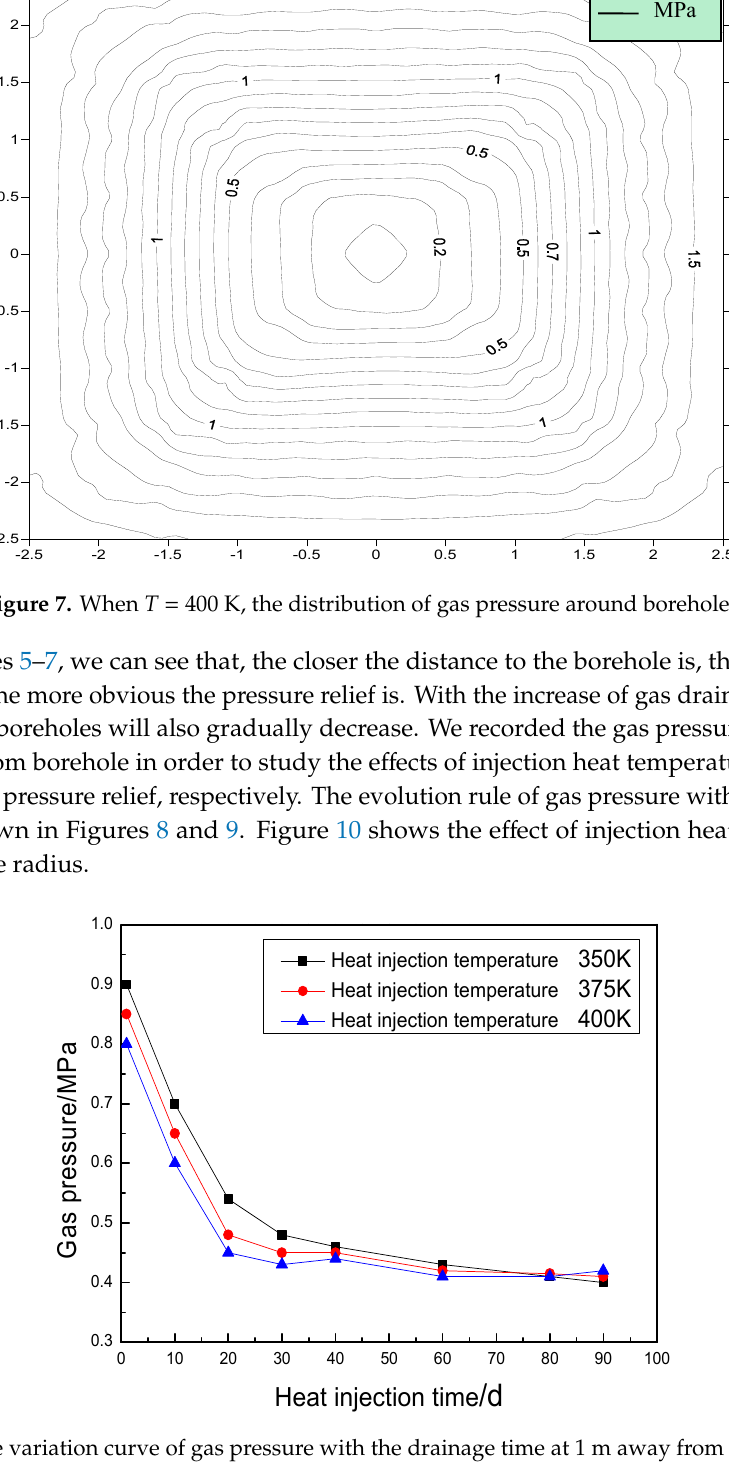
Figure 6. When T = 375 K, the distribution of gas pressure around boreholes.